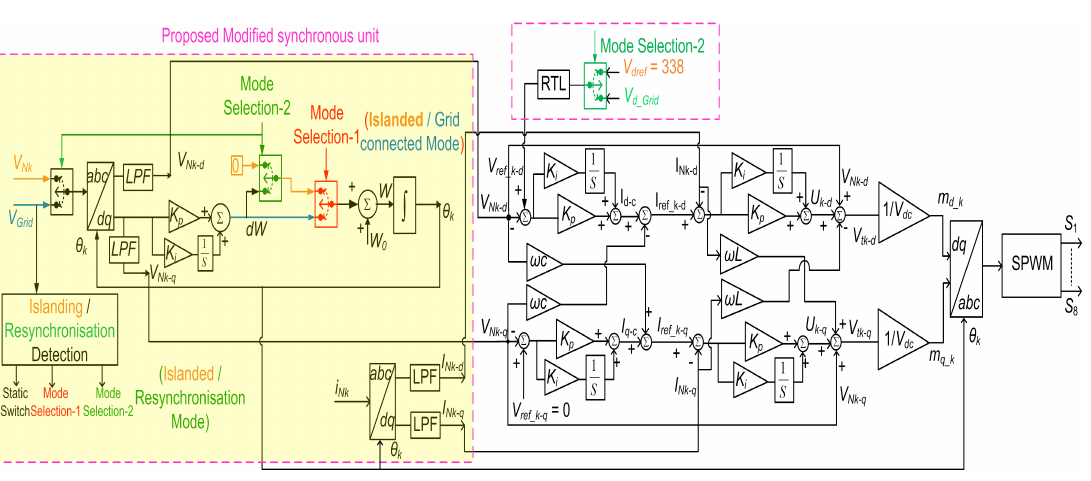
Figure 4. Proposed modified voltage control for DG during islanded operating